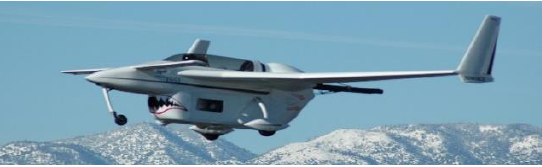
Fig. 3. The first and only flight of aircraft powered by PDE on 31 st of January 2008 at the US Air Force Mojave Air and Space Port [23]